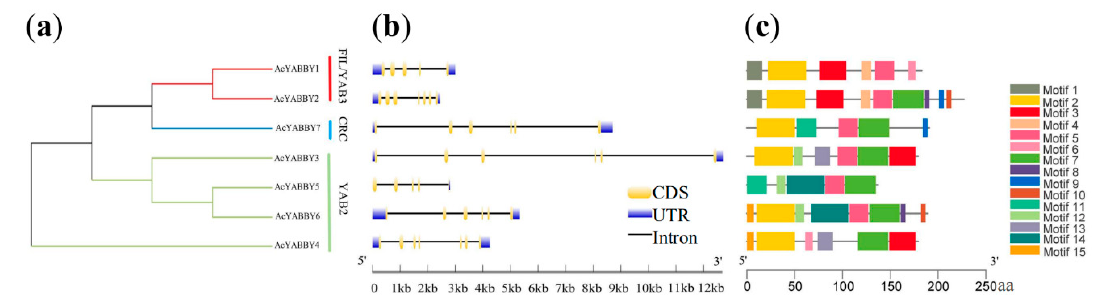
Figure 3. Phylogenetic relationships, gene structure and architecture of conserved protein motifs in pineapple YABBY genes. ( a ) The phylogenetic tree was constructed based on the full ‐ length sequences of pineapple YABBY proteins using MEGA 7 software. Details of clusters are shown in different colors. ( b ) Exon ‐ intron structure of pineapple YABBY genes. Blue boxes represent untranslated 5 ′‐ and 3 ′‐ regions; yellow boxes represent exons; black lines represent introns. ( c ) The motif composition of pineapple YABBY proteins. The motifs, numbers 1–15, are displayed with different colored boxes.